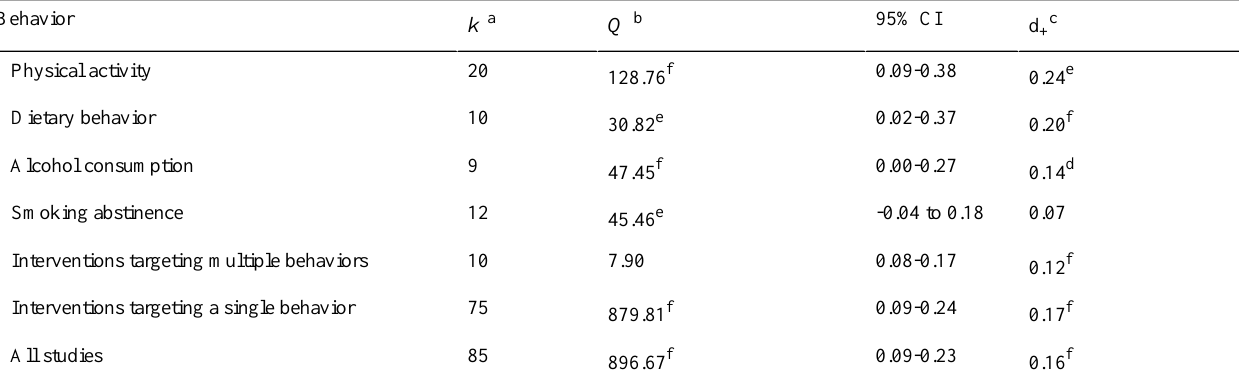
Table 1. Weighted effect sizes (d+) for behavior change as a function of Internet-based interventions by behavior